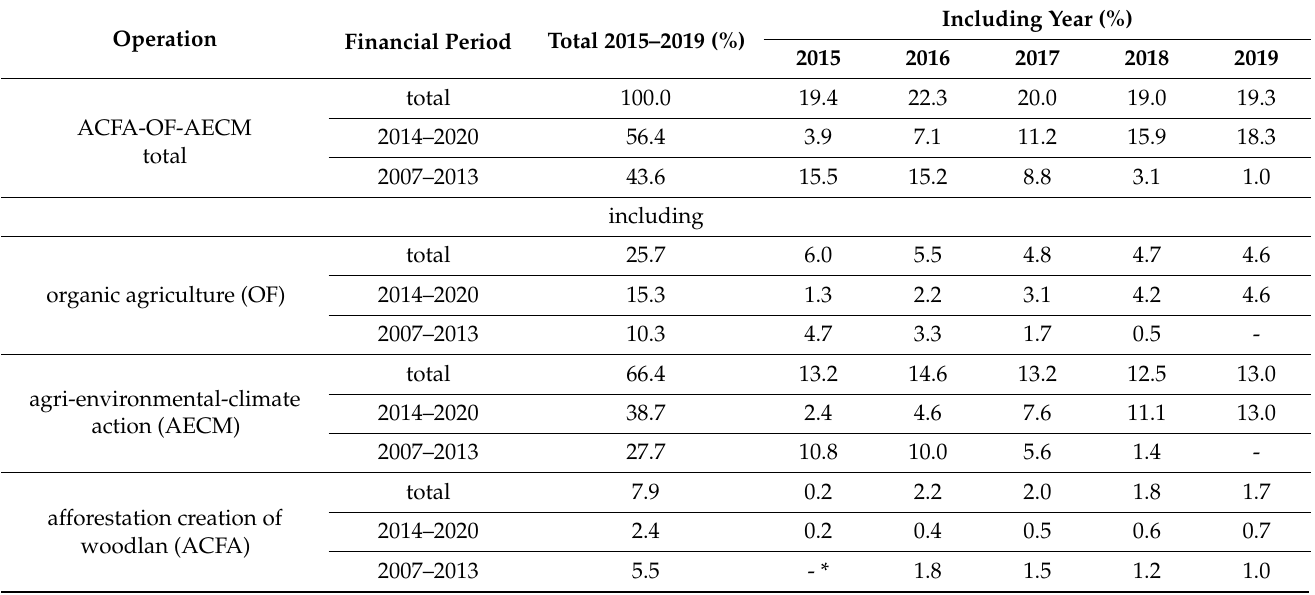
Table 1. Percentage of realised pro-environment applications in the years 2015–2019 (100% = 763.4 thousand